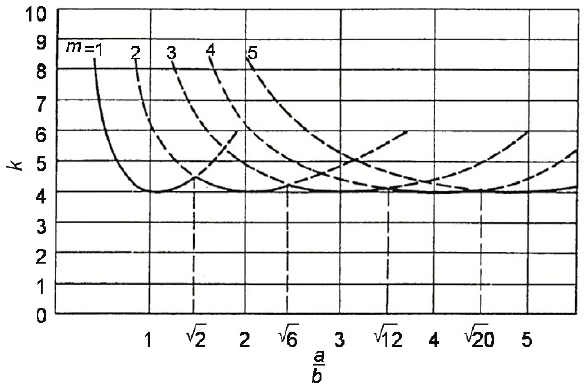
Figure 2. Buckling coefficient for rectangular plate versus the aspect ratio a/b [1].